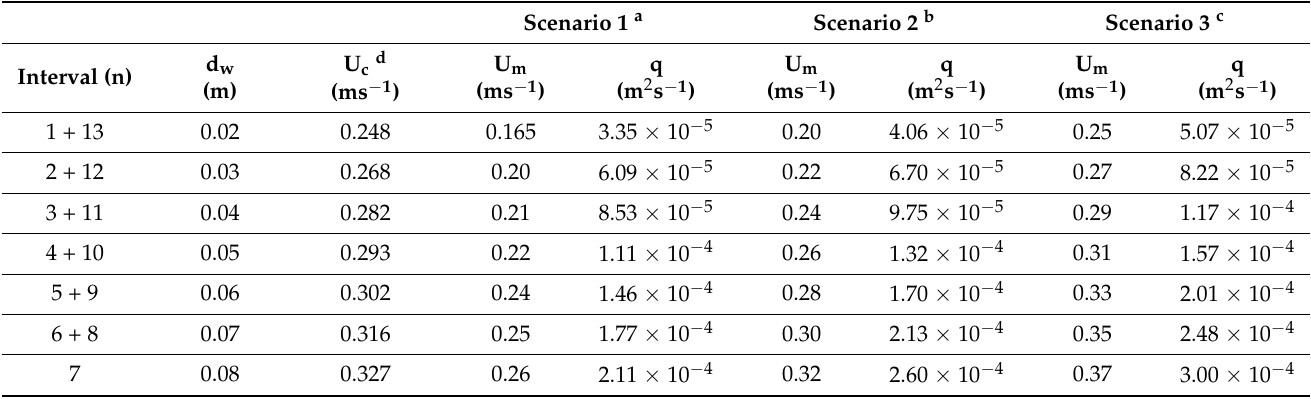
Table 1. Hydraulic boundary conditions of flow intervals used to design hydrographs.